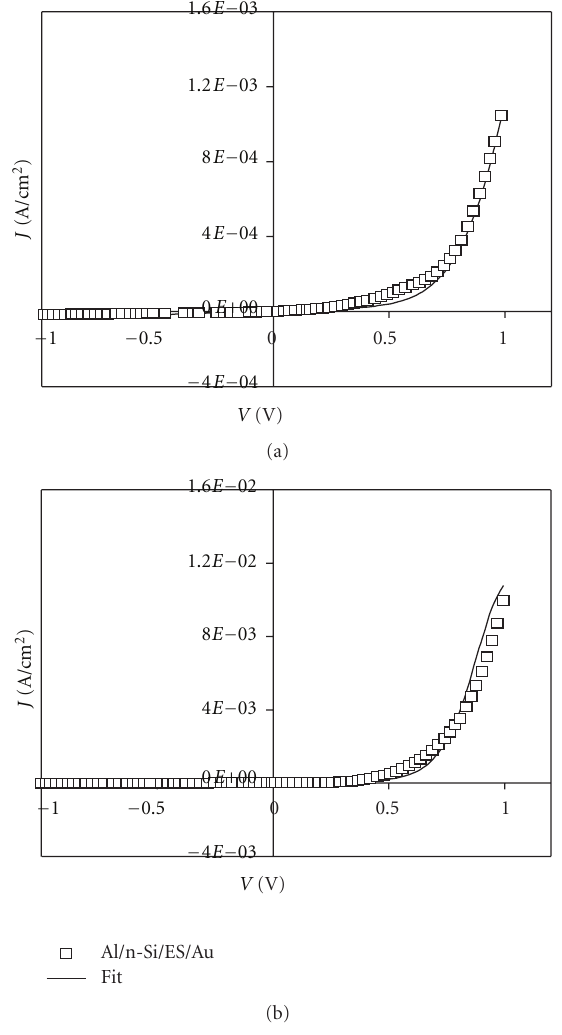
Figure 2: J - V characteristics for Al/PANI-DBSA/n-Si heterojunc- tions under darkness using Au or Ag as Ohmic contact. The solid line represents the expected J - V